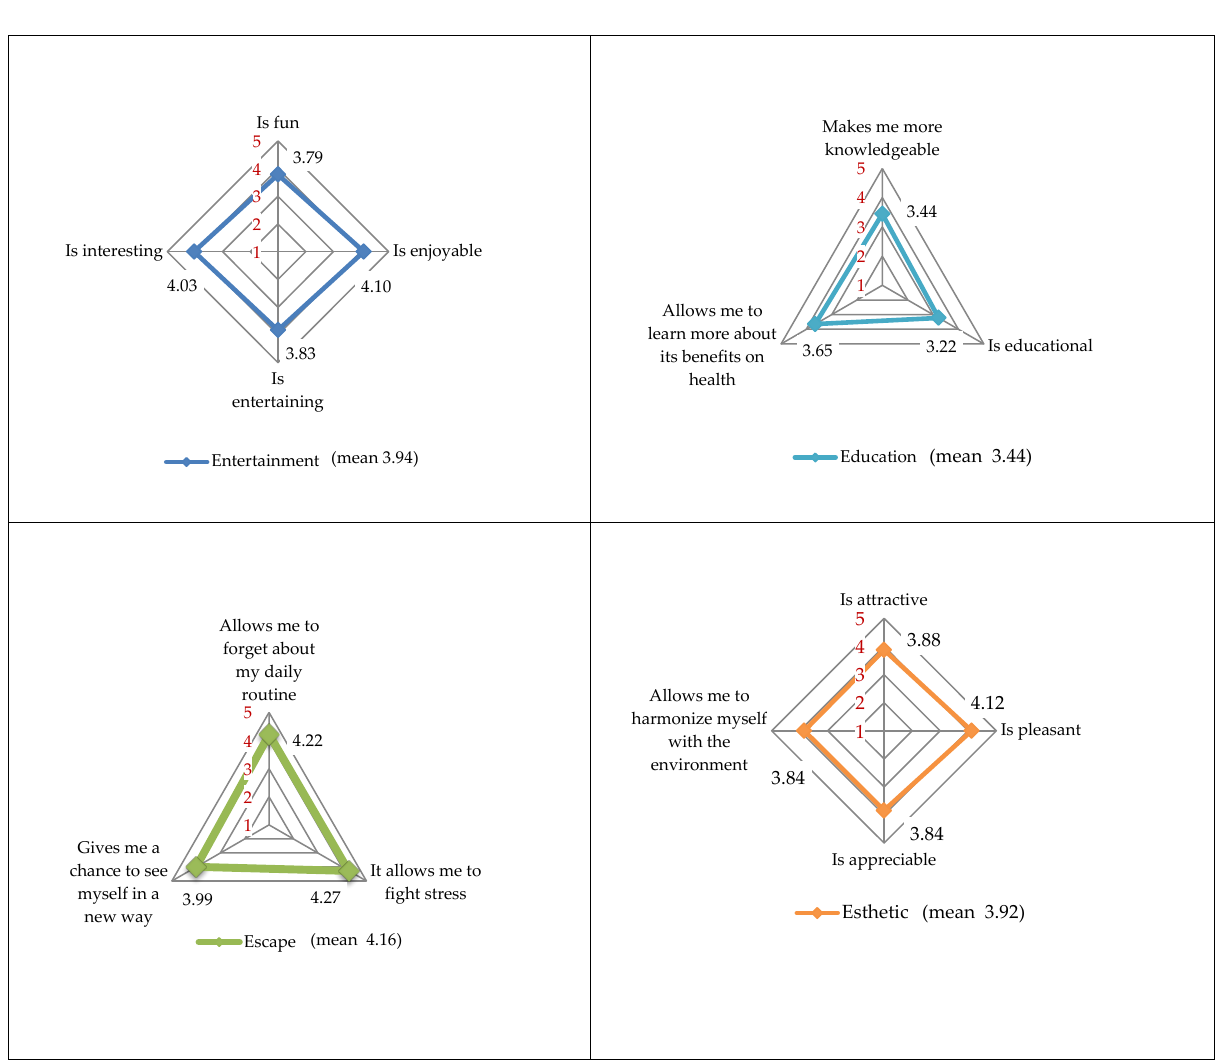
Figure 5. Assessment of the variable Experience